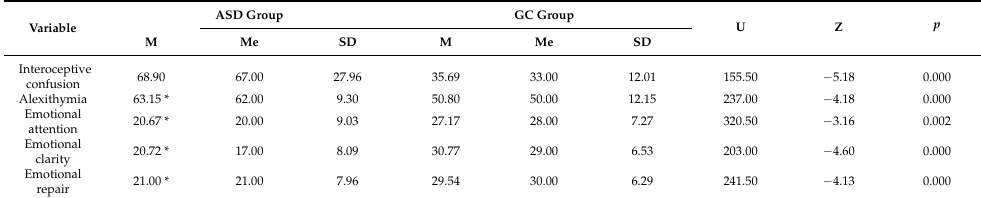
Table 1. Mann–Whitney U test for the ASD and CG groups.